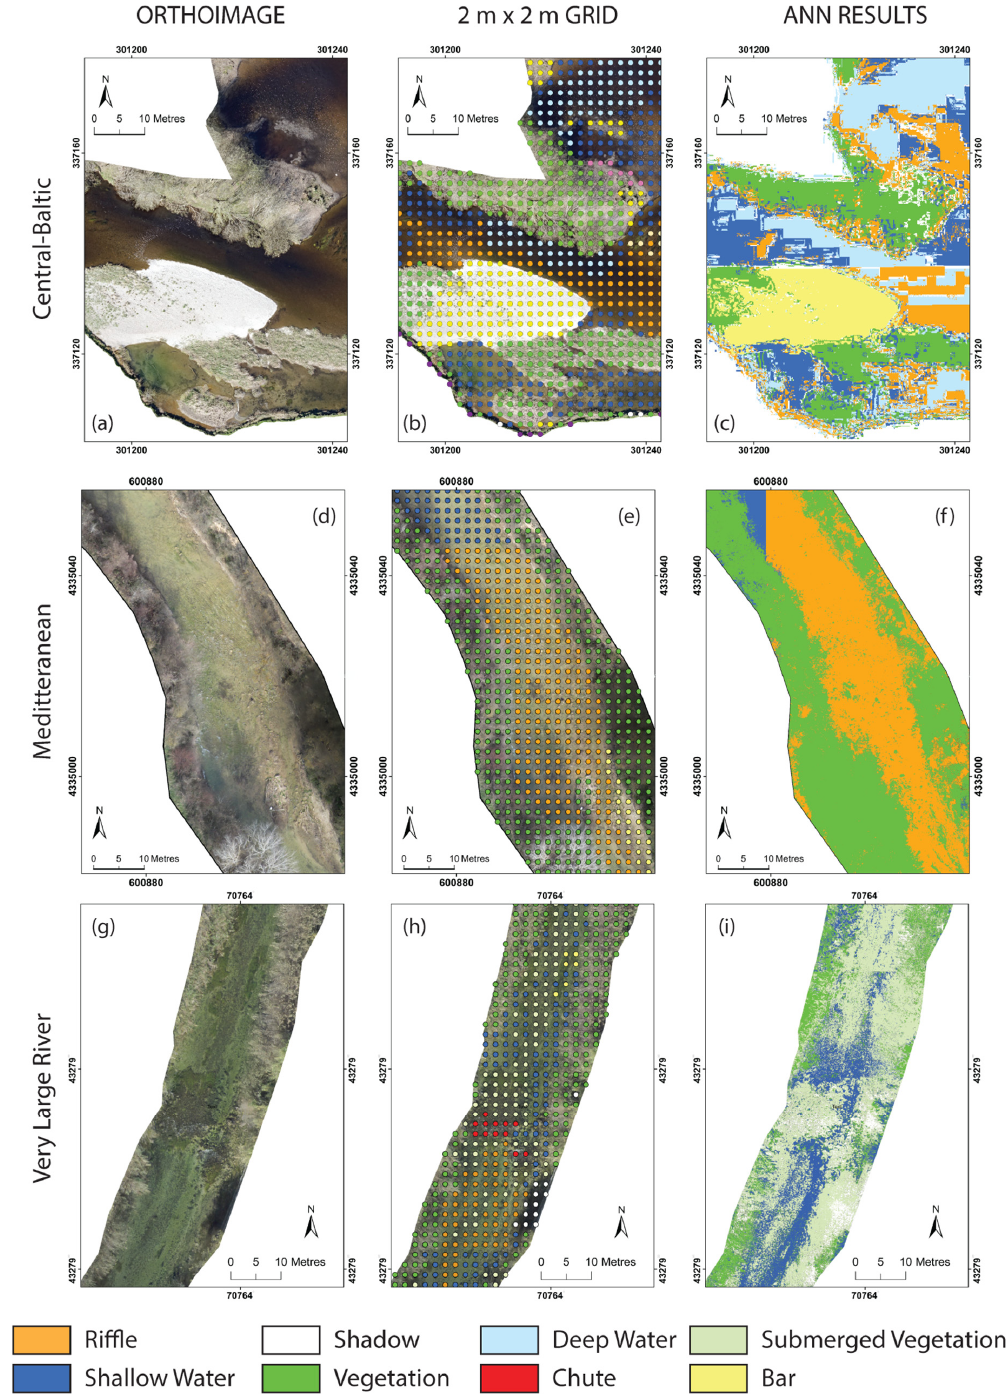
Figure 2. Example of classification outputs obtained for each Geographical Intercalibration Group (GIG). From left to right, orthoimage, 2 m × 2 m ground truth grid and classified outputs from the Artificial Neural Network (ANN); ( a – c ) Outputs for the Central-Baltic GIG reach; ( d – f ) Outputs for the Mediterranean GIG reach; ( g – i ) Outputs for the Very Large Rivers GIG